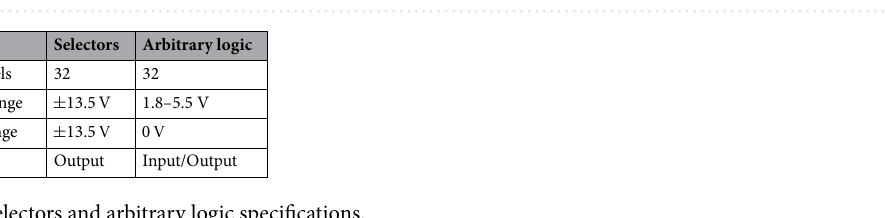
Figure 7. Oscilloscope captures of a variety of pulses produced with the high speed pulse generator. ( a ) +VE pulses starting at 0 V . ( b ) −VE pulses starting at − 0.5V . ( c ) +VE pulses symmetrical around 0 V . ( d ) Continuous pulses starting at 3V .